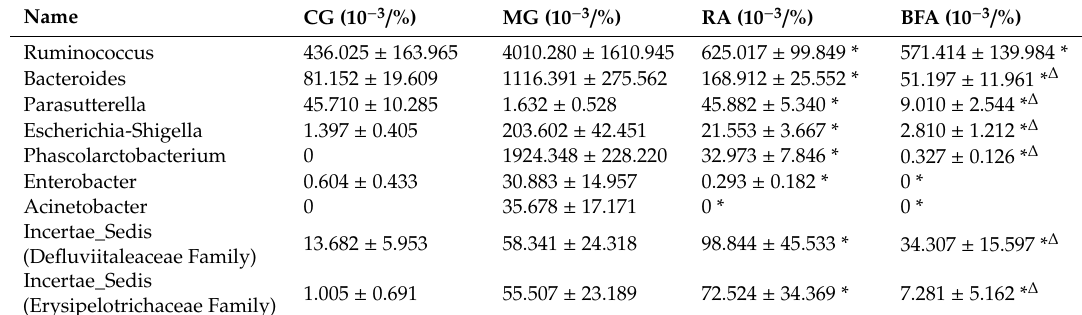
Table 1. The abundance of bacteria closely related to SDS among diverse groups.